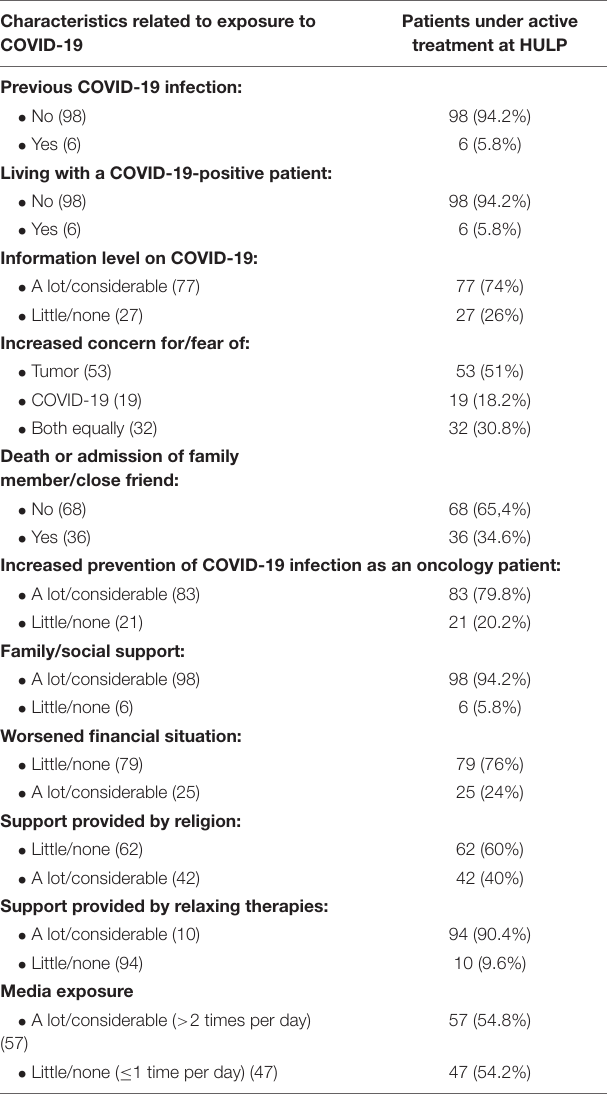
TABLE 2 | Baseline characteristics of the surveyed population ( n =